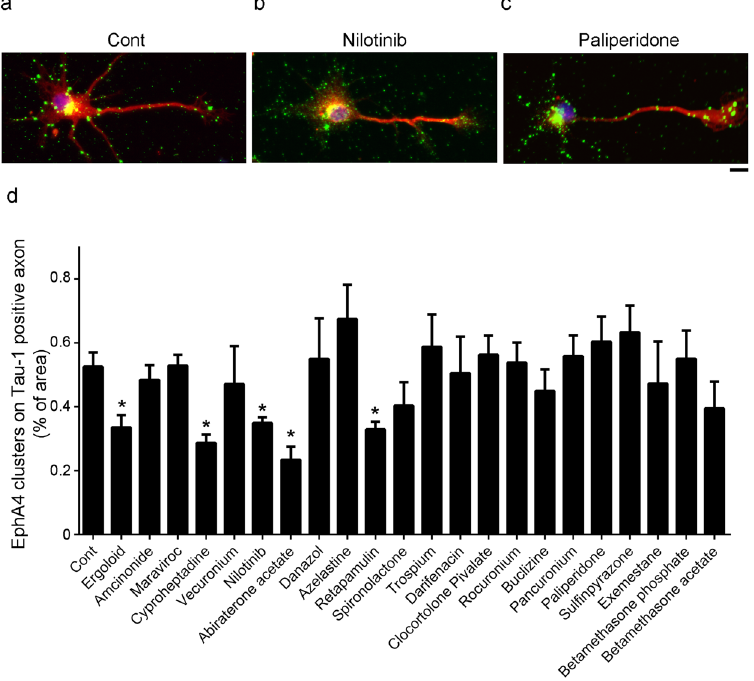
Figure 1. Inhibitory activity of 22 selected FDA-approved drugs in ephrin-A1–induced EphA4 clusters in cultured rat hippocampal neurons. Cultured hippocampal neurons at 3 days in vitro were treated with the candidate drugs (50 μ M), followed by clustered ephrin-A1 (A1). The neurons were then subjected to immunostaining for EphA4 (green) and Tau-1 (red) antibodies. ( a – c ) Representative images of EphA4- and Tau-1–stained neurons. Ephrin-A1 (A1)-treated neurons without drug treatment ( a ), or with pretreatment with nilotinib ( b ) or paliperidone ( c ). ( d ) Quantitative analysis of EphA4 clusters on axons of ephrin-A1–treated neurons. Scale bar = 10 μ m. n = 4 neuronal cell cultures; * p < 0.05 vs. Cont (ephrin-A1 treated neurons alone); unpaired Student’s t